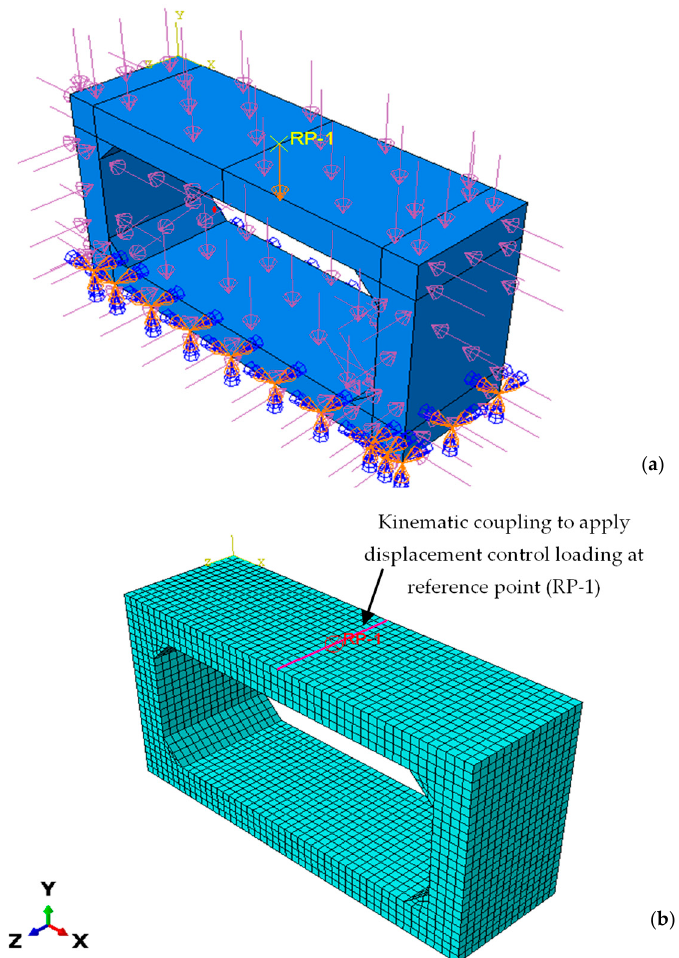
Figure 5. Details of model constrains and loading mechanism; ( a ) model constrains; ( b ) kinematic coupling for displacement-controlled loading.